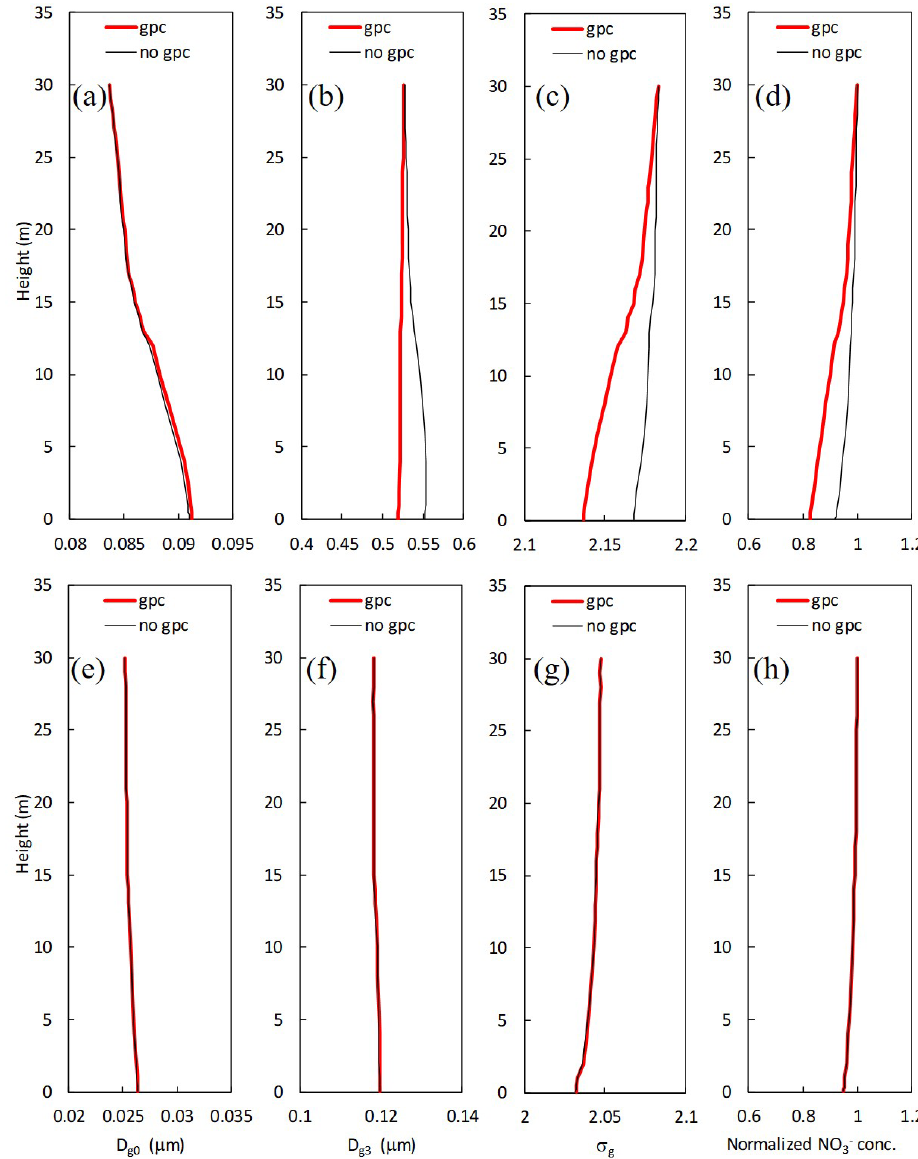
Figure 10. Mean vertical profiles for calculated (a, e) number-equivalent ( D g0 ) and (b, f) mass-equivalent geometric mean wet diameter ( D g3 ), (c, g) standard deviation ( σ g ), and (d, h) normalized mass concentration of NO − scenarios (gpc and no gpc) from 7 November to 7 December